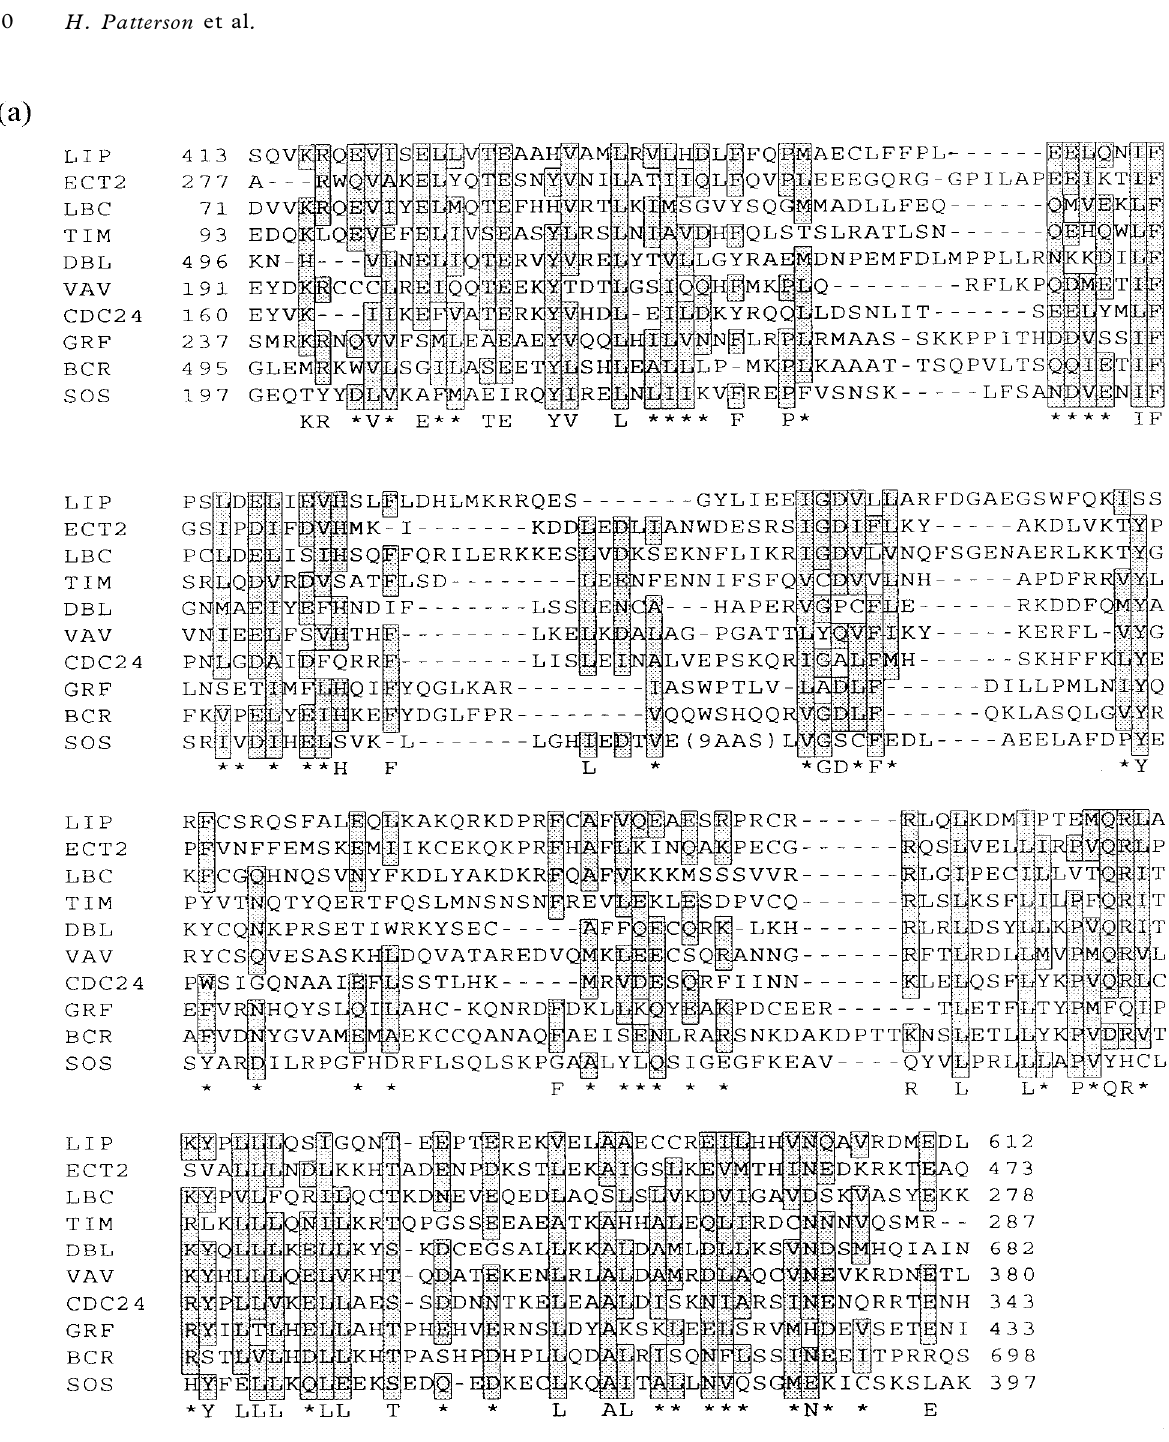
from human fetal brain cDNA libraries. 14 .